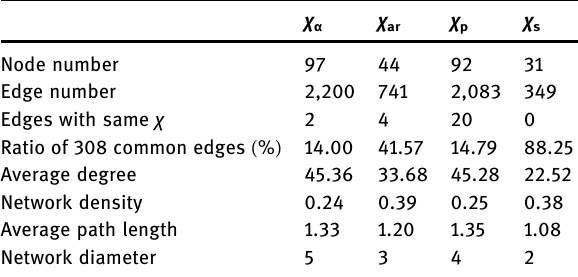
Table 3: Basic topological parameters of the four DCBNs